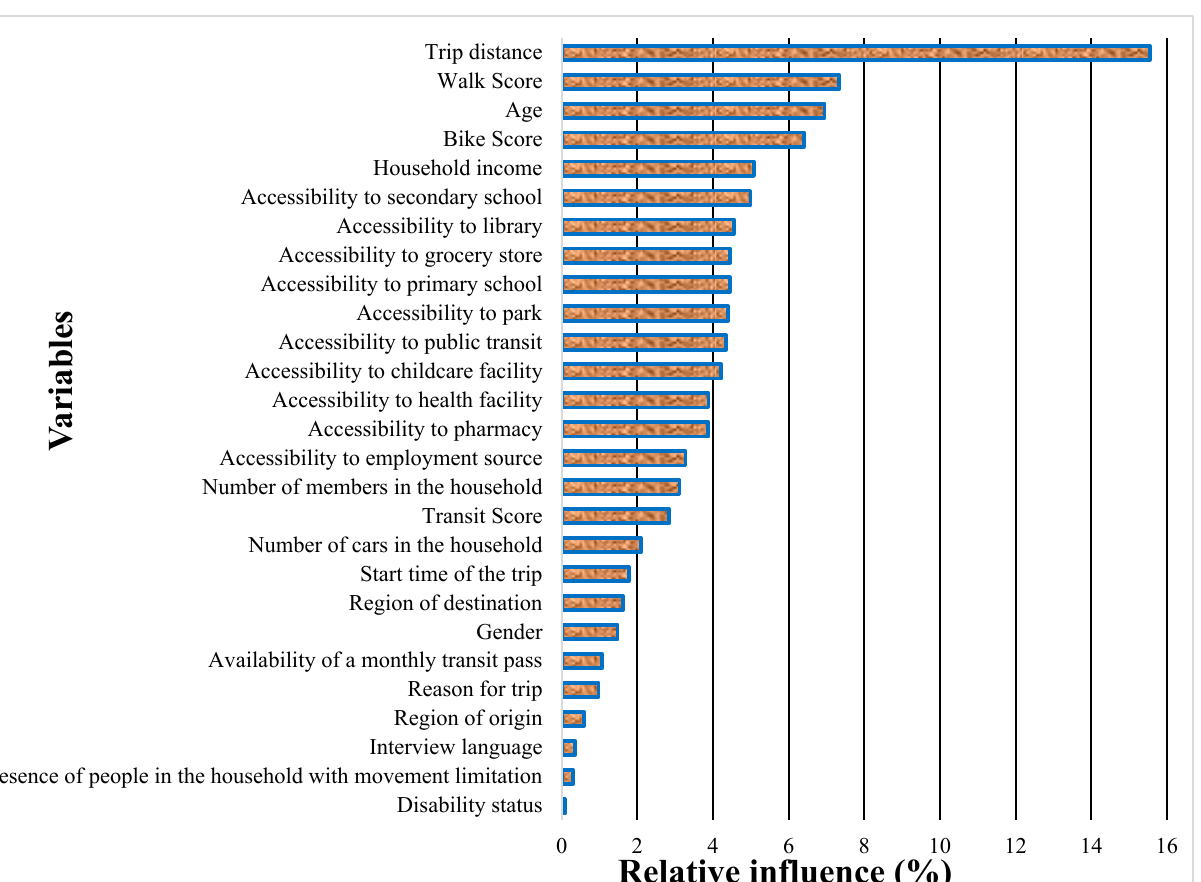
Table 5. Results of multiple logistic regression (variables are organized by relative influence from most to least).